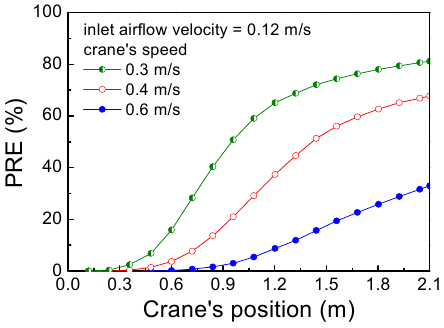
Figure 10. Variations in the particle removal efficiency (PRE) related to the crane’s positions.